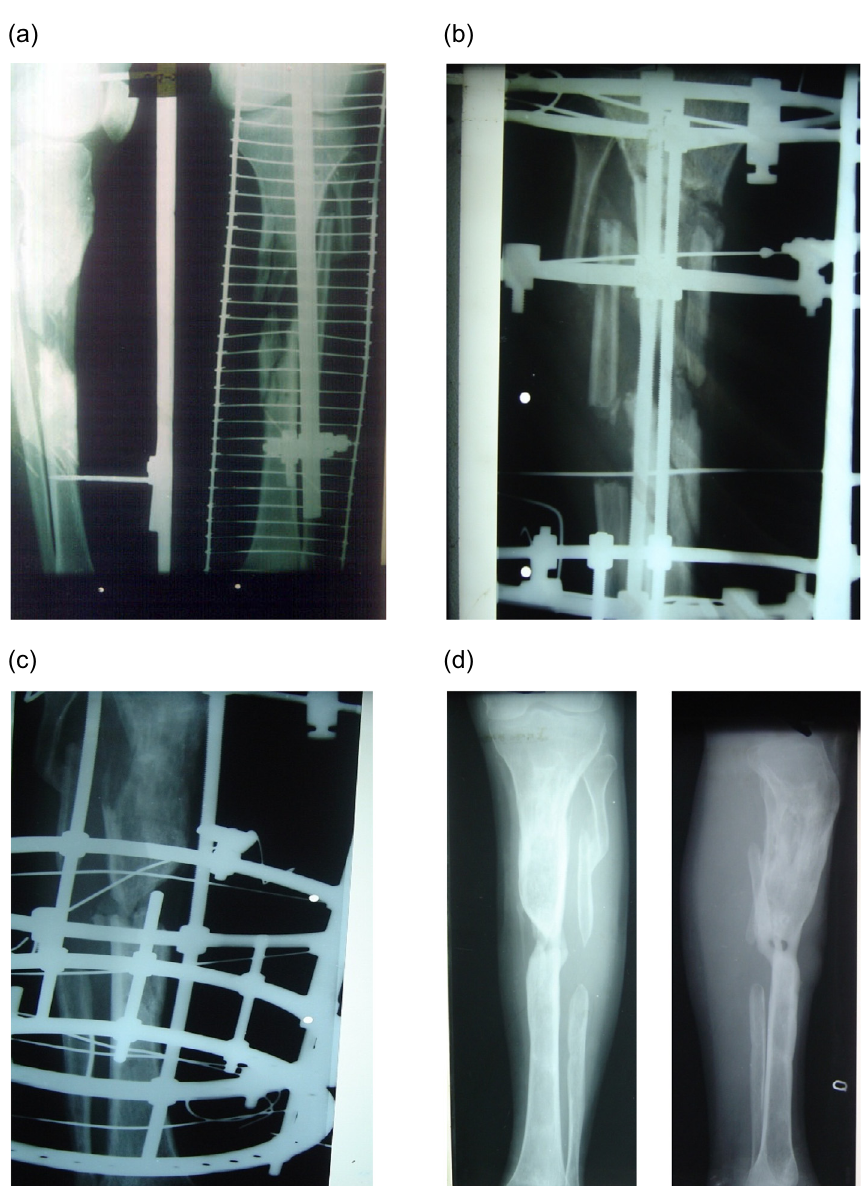
Figure 1. (a) AP and lateral pre-op X-rays showing Frank non-union with bone loss, (b) After applying IRF, corticotomy done at proximal tibia, (c) while undergoing distraction, (d) A/P and lateral views after